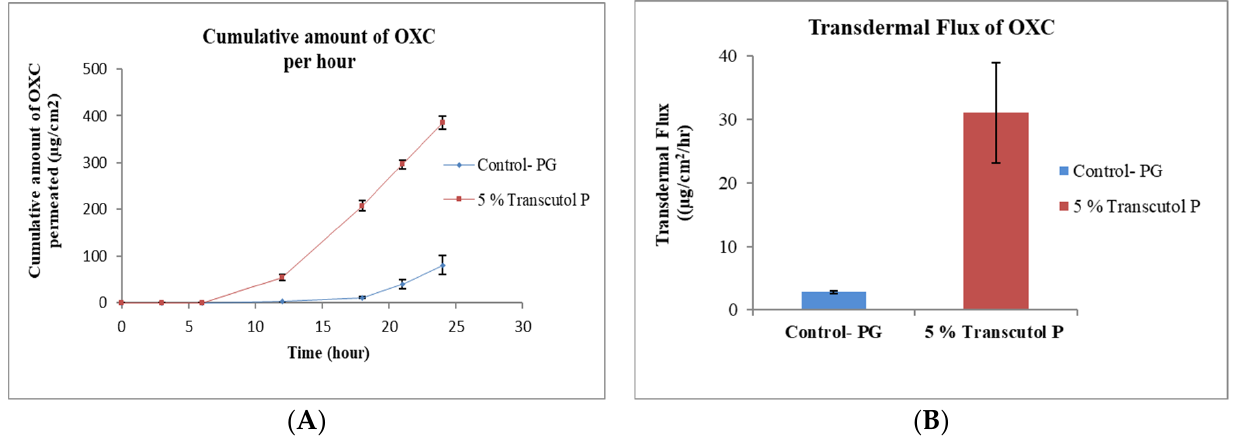
Figure 1. In vitro cumulative amount of OXC permeated per unit area versus time ( A ) and trans- dermal flux of OXC ( B ) across the human cadaver skin in presence or absence of Transcutol ® P. Each point represents the mean ± S.D. of three replicates in the absence of multiple donors.